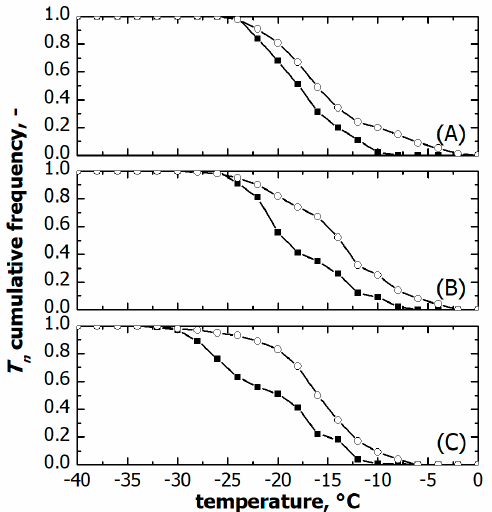
Figure 7. Comparison between cumulative ice nucleation temperature distributions of vials nested in a rack system ( ○ ) and in direct contact with the shelf ( ■ ). Data refer to various cooling rates: ( A ) 0.25, ( B ) 0.50, and ( C ) 1.00 °C min − 1 .